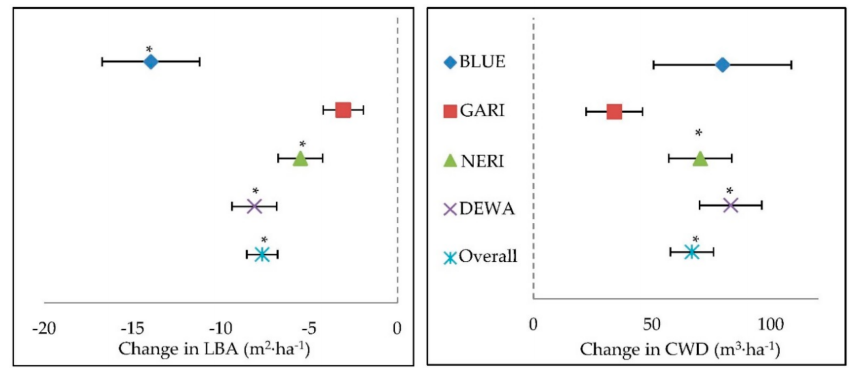
Figure 1. Tukey method comparison for differences of means (disturbed–undisturbed) for change in live basal area (m 2 · ha − 1 ) ( left panel ) and coarse woody debris (m 3 · ha − 1 ) ( right panel ) between disturbed and undisturbed plots for each National Park Service (NPS) unit and for all the units combined following the disturbance events. The error bars represent +/ − one standard error of the difference. Asterisks represent a p -value of <0.05, indicating a significant difference in the changes in LBA between disturbed and undisturbed plots. Table A1 contains a list of the means and sample sizes. Appendix A and Table A5 contain the values for the differences of means, standard error, and p -values. The y -axis (dashed line) meets the x -axis (solid line) at zero. Pre- and post-disturbance means as well as standard errors can be found in Table S1.